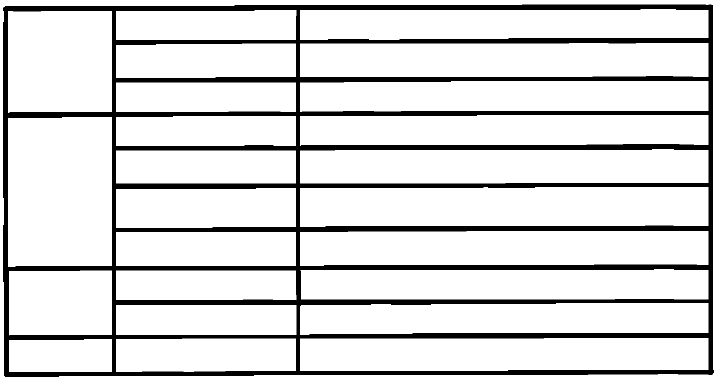
Figure 7. Table frame